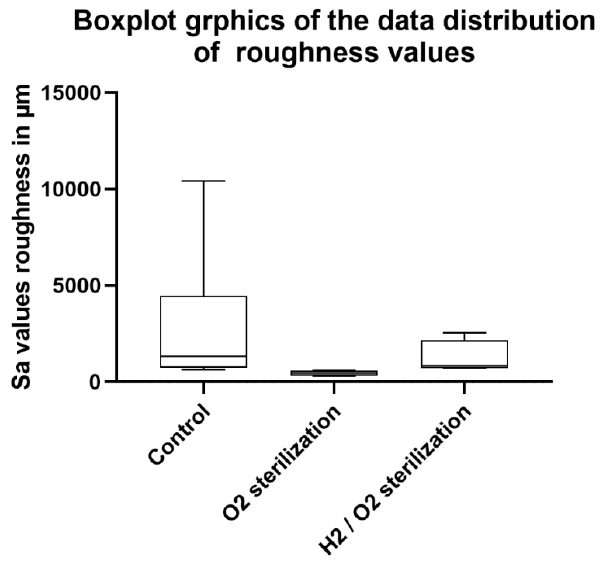
Figure 8. Boxplot graphics of the data distribution of surface roughness measurements before (control) and after plasma sterilization. No significant differences in the median values were found.